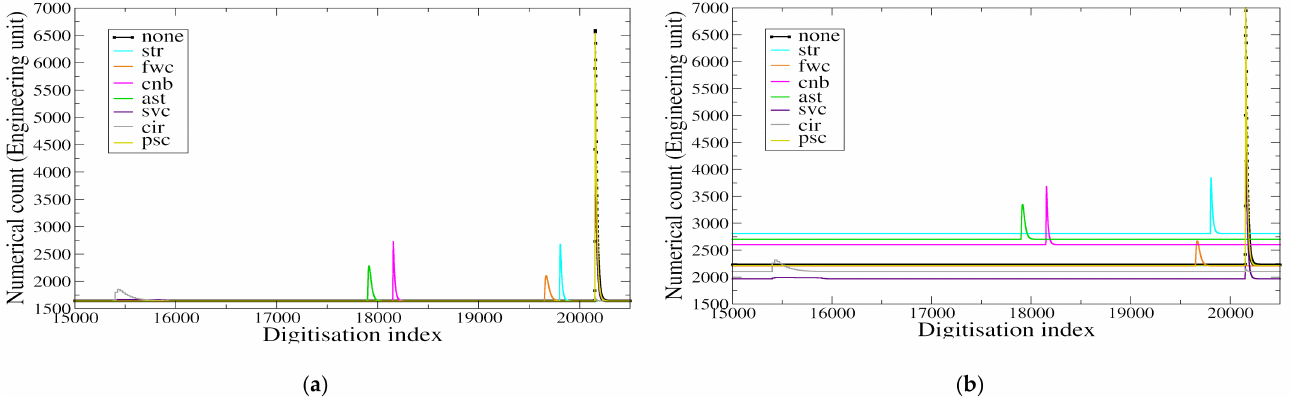
Figure 18. Position and strength of cloud and ground signals for various cloud types (see Figure 7) for a solar zenith angle (SZA). ( a ) SZA = 90 ◦ . ( b ) SZA = 70 ◦ . The rightmost peak around 20,200 is the ground echo.